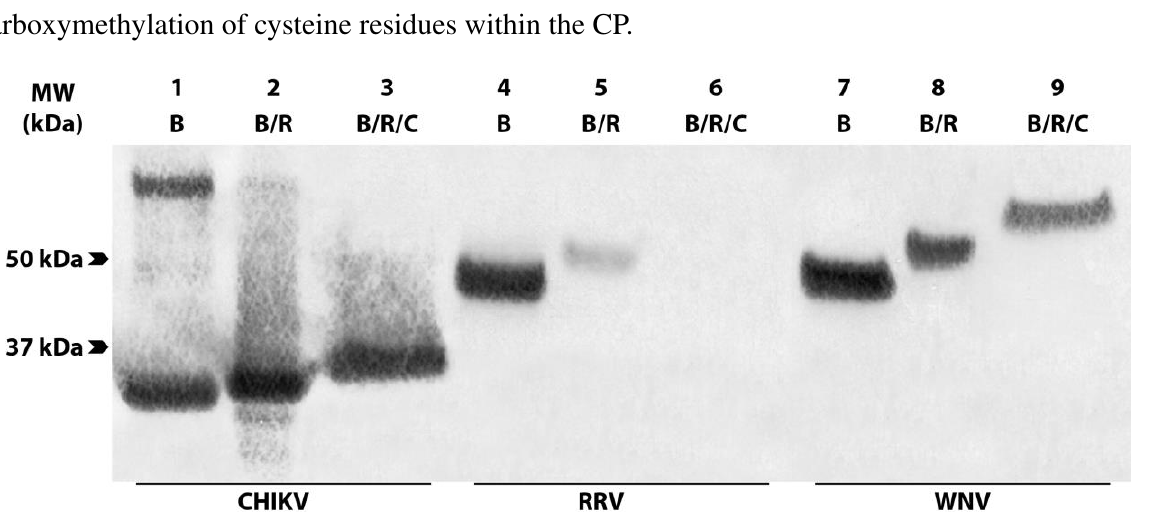
Figure 2. Reactivity of anti-CHIKV CP mAbs against boiled, reduced and/or carboxymethylated CHIKV cell lysates. Boiled (B), boiled and reduced (B/R) or boiled, reduced and carboxymethylated (B/R/C) lysates of CHIKV (lanes 1–3), RRV (lanes 4–6) and West Nile virus (lanes 7–9) were probed with antibodies 1.7B2 (anti-CP), RRG8 (anti-E1) and 17D7 (anti-E), respectively, in Western blot. RRV and West Nile virus lysates were included as controls to illustrate binding of reference antibodies known to recognize conformational (RRG8) and linear epitopes (17D7) respectively.